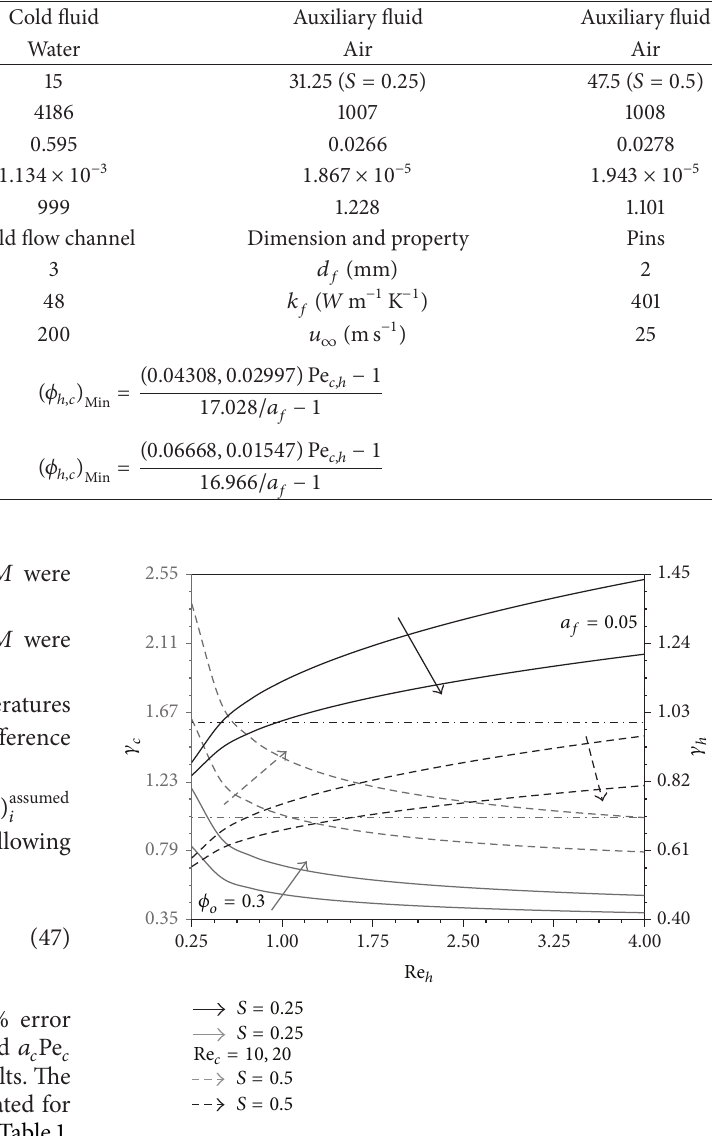
Figure 3: Effects of Re ℎ and Re 𝑐 on 𝛾 ℎ and 𝛾 𝑐